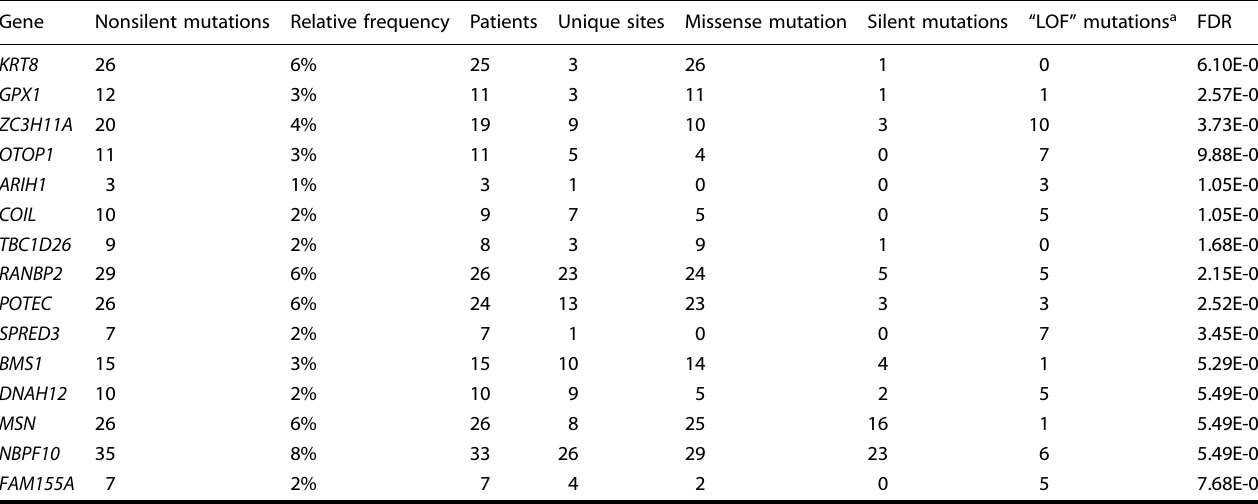
Table 1. Novel signi fi cantly mutated genes not previously reported on in cervical carcinoma. Gene Nonsilent mutations Relative frequency Patients Unique sites Missense mutation Silent mutations “ LOF ” mutations a FDR